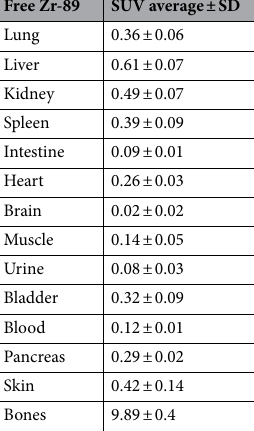
Table 4. Uptake (SUV) and distribution of [ 89 Zr]ZrCl 4 in athymic nude mice (n = 3) at day 7